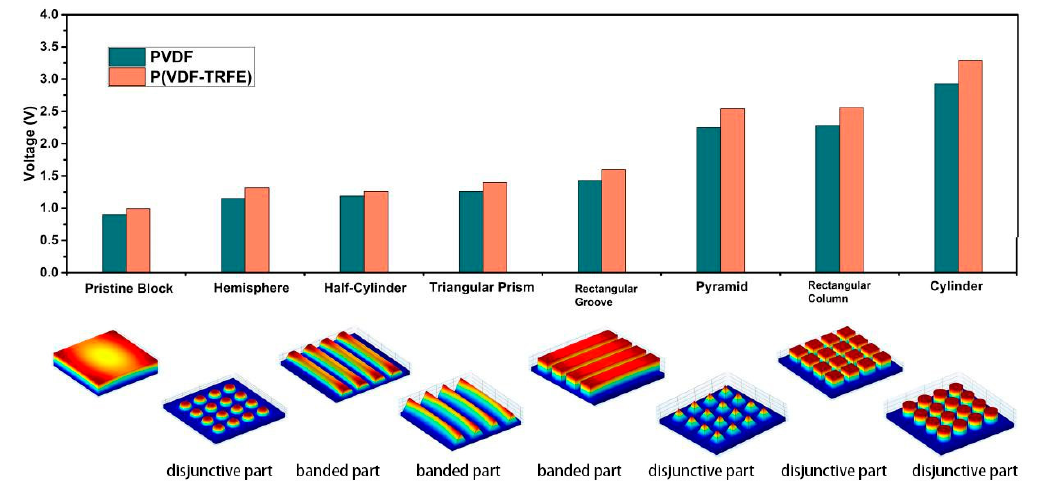
Figure 5. Voltage comparison of eight structures. The small diagrams below are voltage nephogram of eight designs. The left coordinate axis denotes the voltage output.